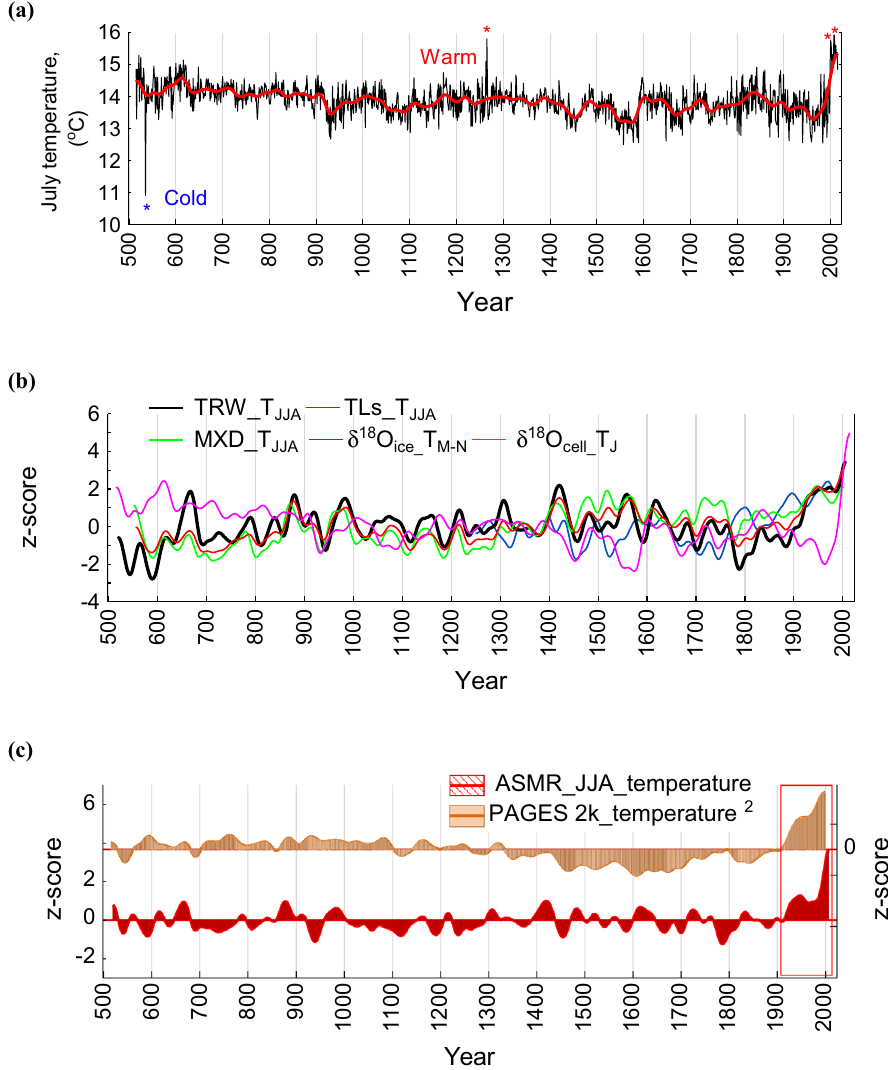
Figure 3. Annually resolved (grey line) and smoothed by a 101-year Hamming window (red line). July air temperature reconstruction are derived from δ 18 O cell for the period from 516 to 2016 CE (this study) ( a ); in comparison with smoothed by a 101-year Hamming window summer June, July, August (JJA) air temperature reconstructions derived from tree-ring width 9,10,13 , maximum latewood density (MXD) 15 . The Teletskoe Lake core sediments (TLs) are derived from the geochemical elements (Ca, Ti, Sr/Br) (this study) and March– November temperature reconstruction inferred from Belukha ice core 27,28 and the newly developed July temperature reconstruction derived from δ 18 O cell in comparison ( b ); and newly developed Altai-Sayan mountain range (ASMR) JJA-air temperature reconstruction (ASMR-T JJA ) based on tree-ring parameters (δ 18 O cell , TRW, MXD) and geochemical elements from the TLs (Ca, Ti, Sr/Br) in comparison with the PAGES 2k global annual (T ann ) and smoothed by a 101-year Hamming window (T sm101 ) air temperature reconstruction 2 ( c